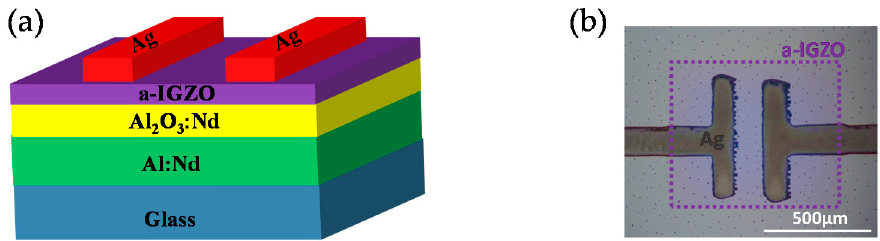
Figure 1. ( a ) Schematic of a-IGZO TFT with inkjet printing Ag S/D electrodes; ( b ) Optical microscope image of device finally fabricated.